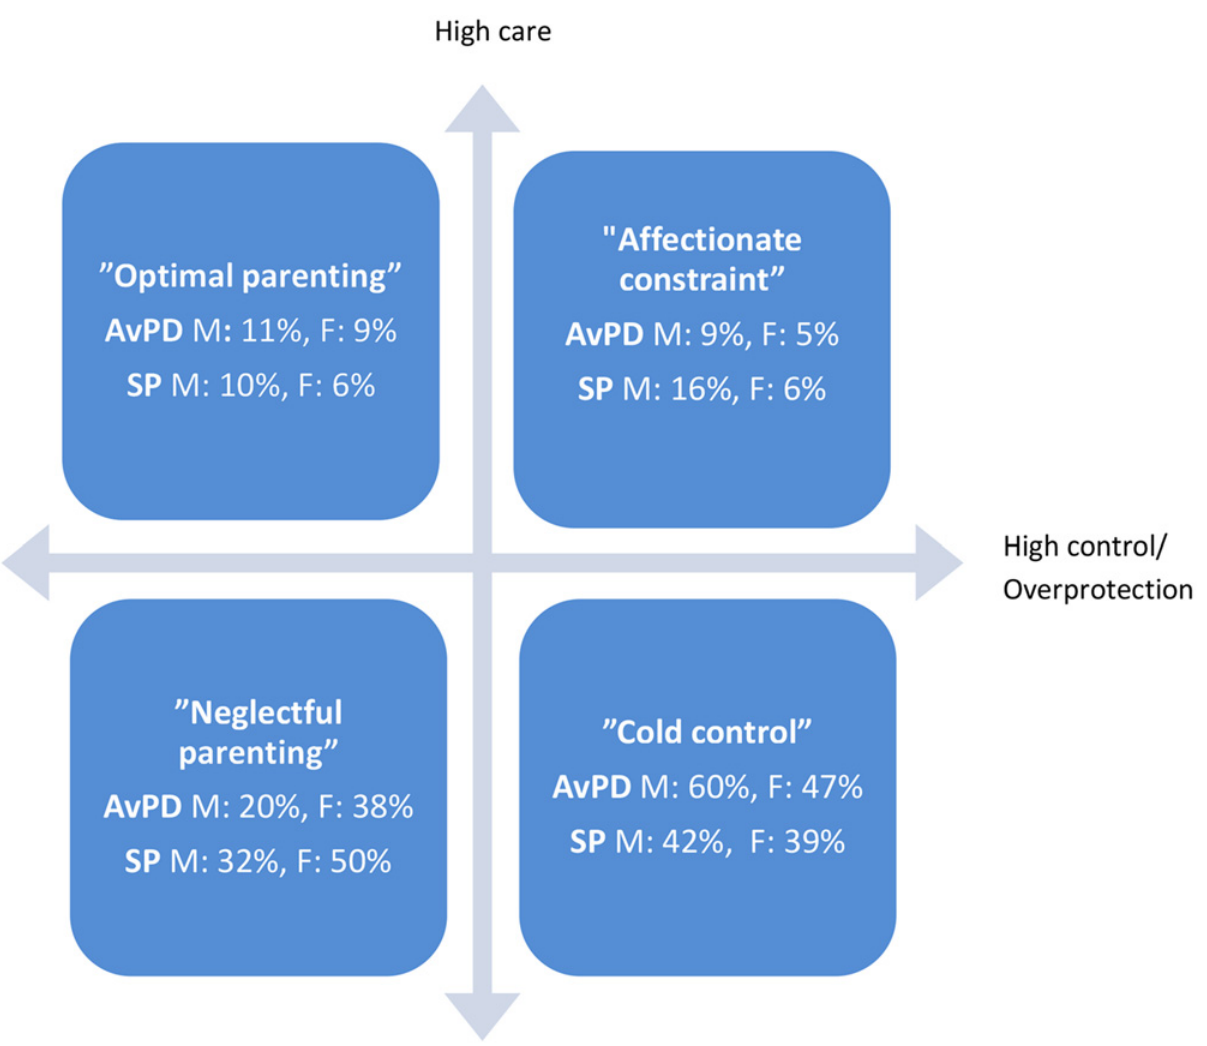
Fig 1. Attachment style in Avoidant personality disorder (AvPD, n = 70) and Social phobia (SP, n = 20). Distribution of the AvPD and SP groups in the two dimensional, four categorical parental style model according to the Parental Bonding Instrument (PBI). ORIGO is defined as the cut-off scores, se